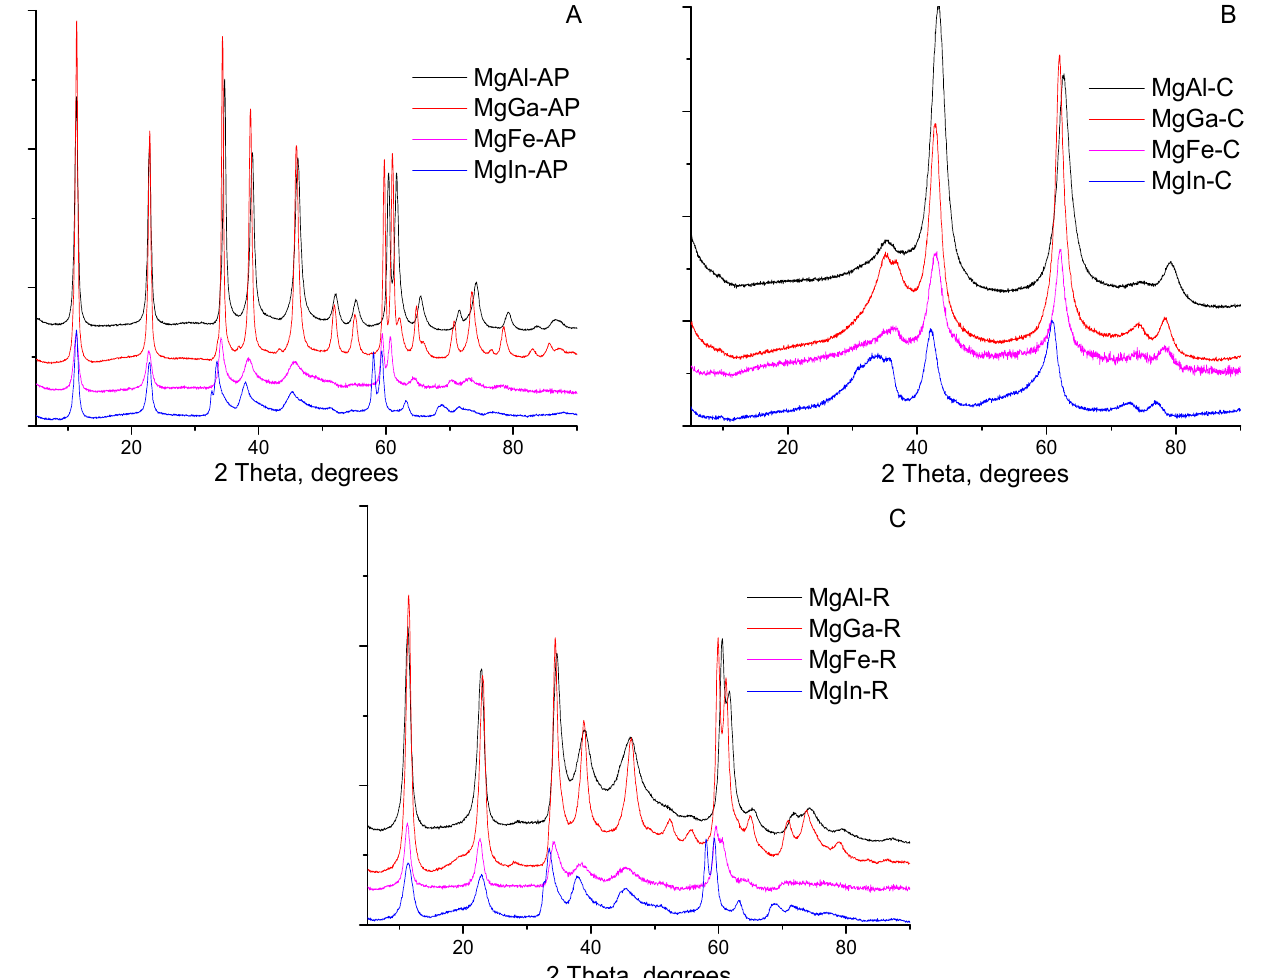
Figure 1. XRD patterns of as-prepared ( A ), calcined ( B ), and rehydrated ( C ) MgAl, MgGa, MgFe, and MgIn samples. Table 2. Crystallinity, lattice parameters, and crystallite size (L(Å)) of the prepared samples.